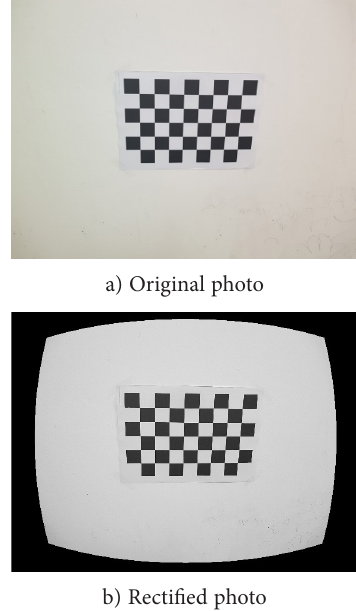
Figure 4. Image rectification for a photo sample captured from wide-angle